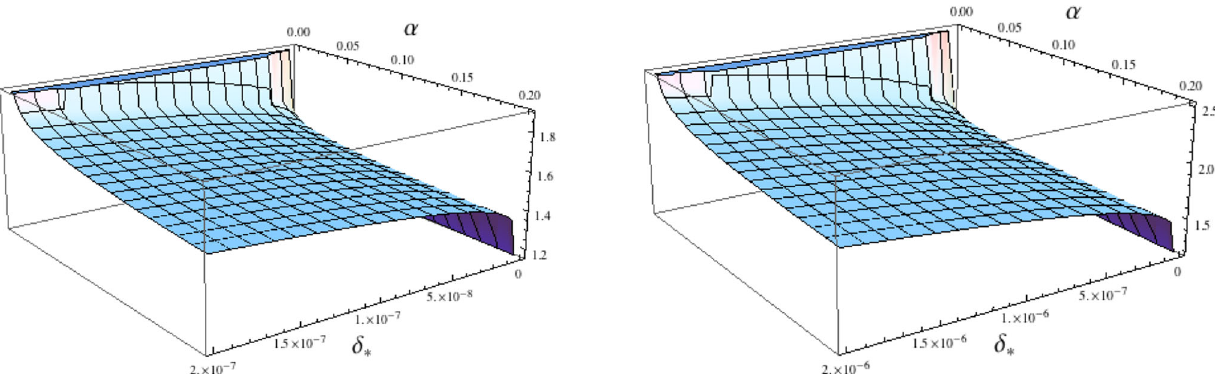
Fig. 3 Figures show the behavior of n against δ (cid:25) and α given by Eq. (4.21). A vertical axis represents values of n . For the plots we have used N = 60 (left panel) and N = 70 (right panel)